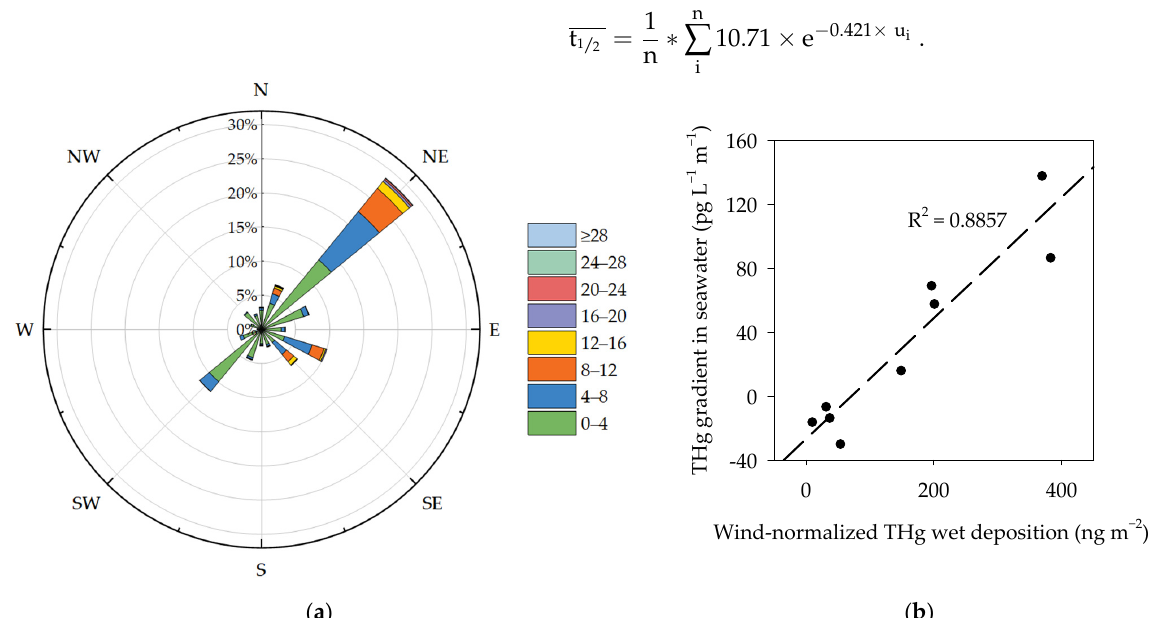
Figure 6. ( a ) Wind-rose diagram of mean hourly wind speeds (m s − 1 ) at the Split-Marjan station during the study period; ( b ) correlations between THg gradient Γ 0–5 in seawater with wind-normalized THg wet deposition.